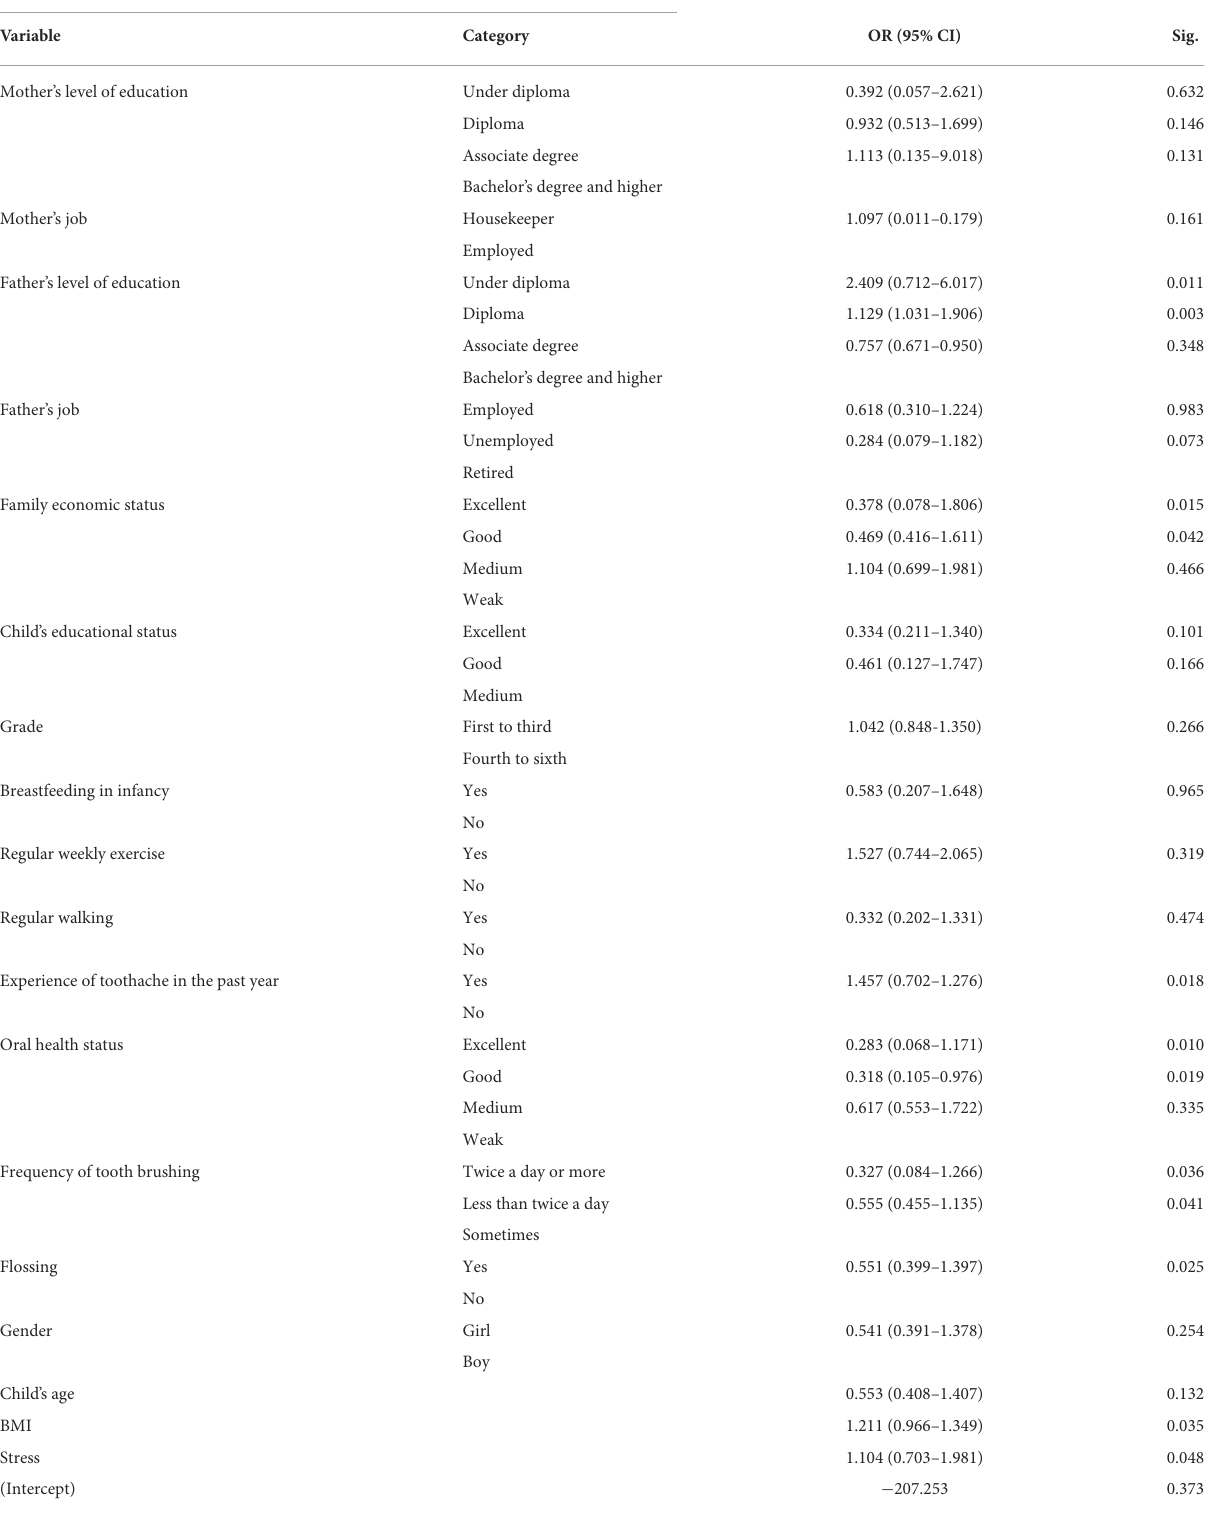
TABLE 3 Factors affecting tooth decay among students in the test of GLM with Binary logistic regression